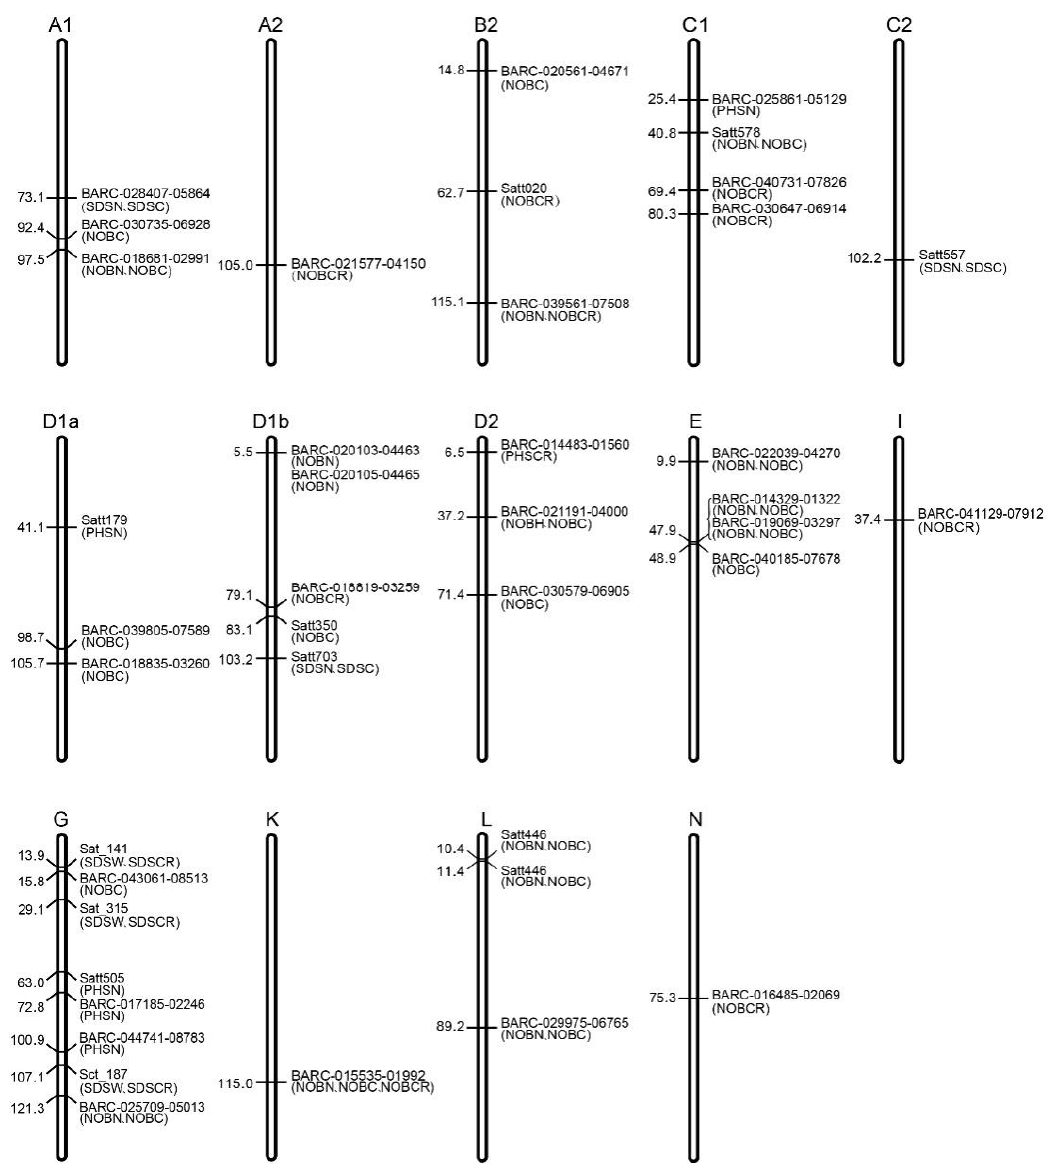
Figure 3. Soybean genetic linkage map showing the marker positions and estimated map distances (cM; indicated on the left of the vertical bars) based on the linkage map of soybean, A1, A2, B2, C1, C2, D1a, D1b, D2, E, I, G, K, L, N are the name of linkage groups (https://www.soybase.org, accessed on 12 July 2021). Putative markers associated with SDSN, PHSN, SDSC, PHSCR, NOBC, SDSL,